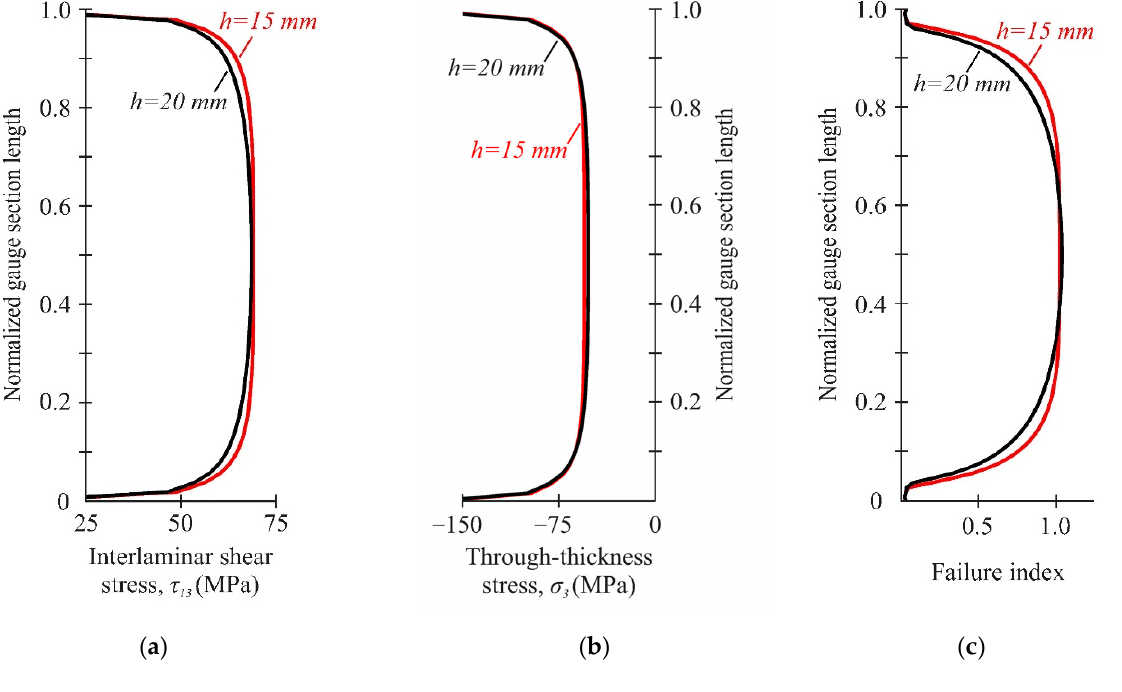
Figure 6. Distribution of interlaminar shear stresses ( a ), through-thickness stresses ( b ), and failure indexes NU-Daniel ( c ) between the notches at different specimen heights.